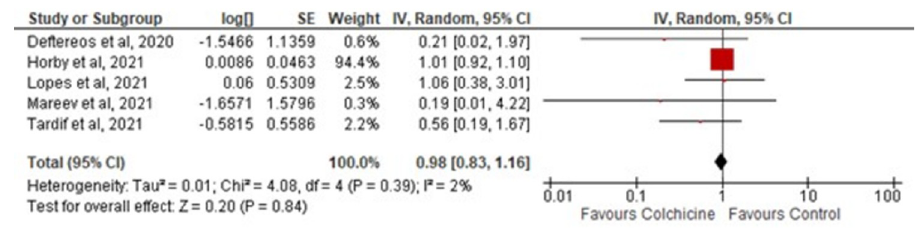
Fig 3. Forest plot for the effect of colchicine on COVID-19 patients. Red squares and their corresponding lines are the point estimates and 95% confidence intervals per each study. Black diamonds represent the pooled effect estimate.